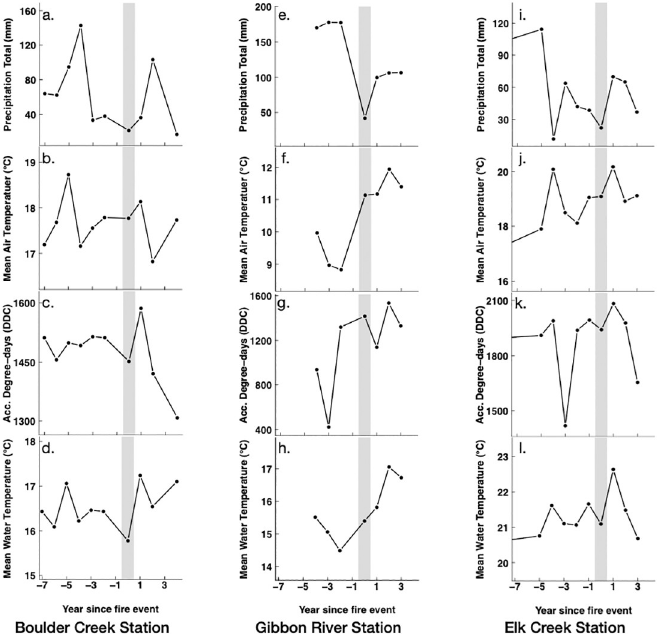
Fig 3. Times series of pre- and post-fire summer precipitation totals, mean air temperatures, accumulated degree days, and mean water temperatures at (a-d) Boulder Creek, (e-h) Gibbon River, and (i-l) Elk Creek sites. Grey line represents the fire year.